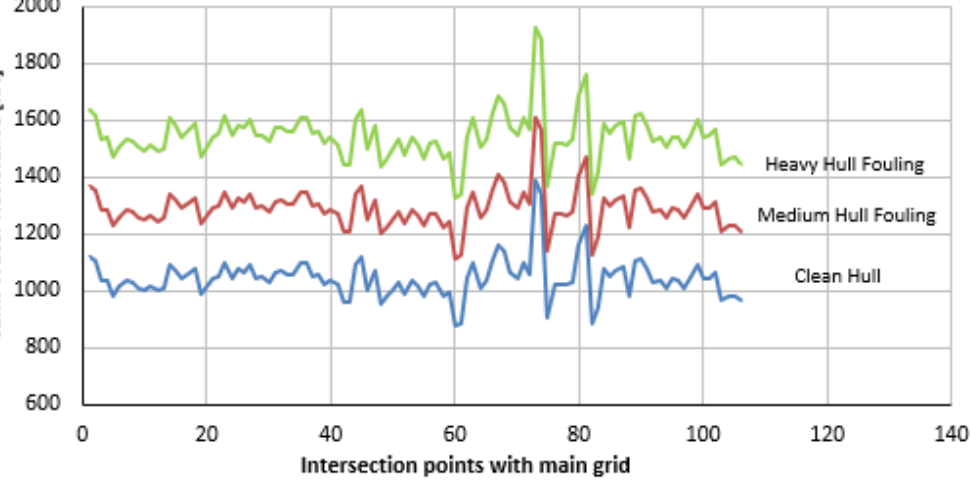
Figure 6. Calm water resistance increase due to fouling along the orthodrome path. When the propeller’s fouling is added to the problem, fuel oil consumption (FOC) increased by 15% compared with the fouled hull with a clean propeller (Table 3).